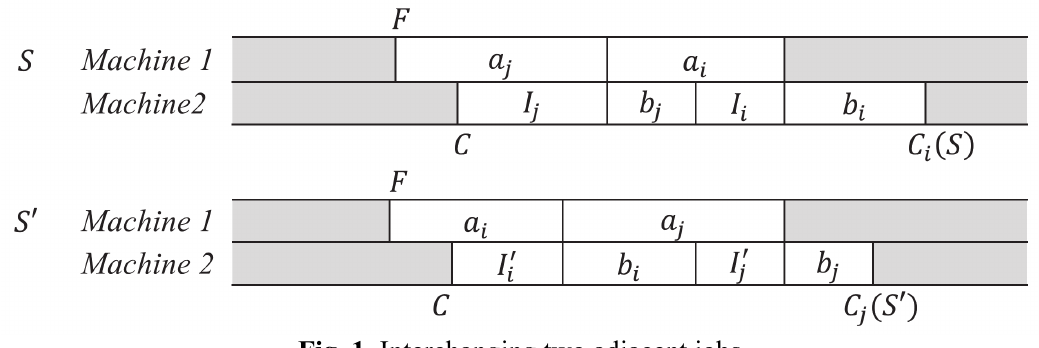
Fig. 1. Interchanging two adjacent jobs